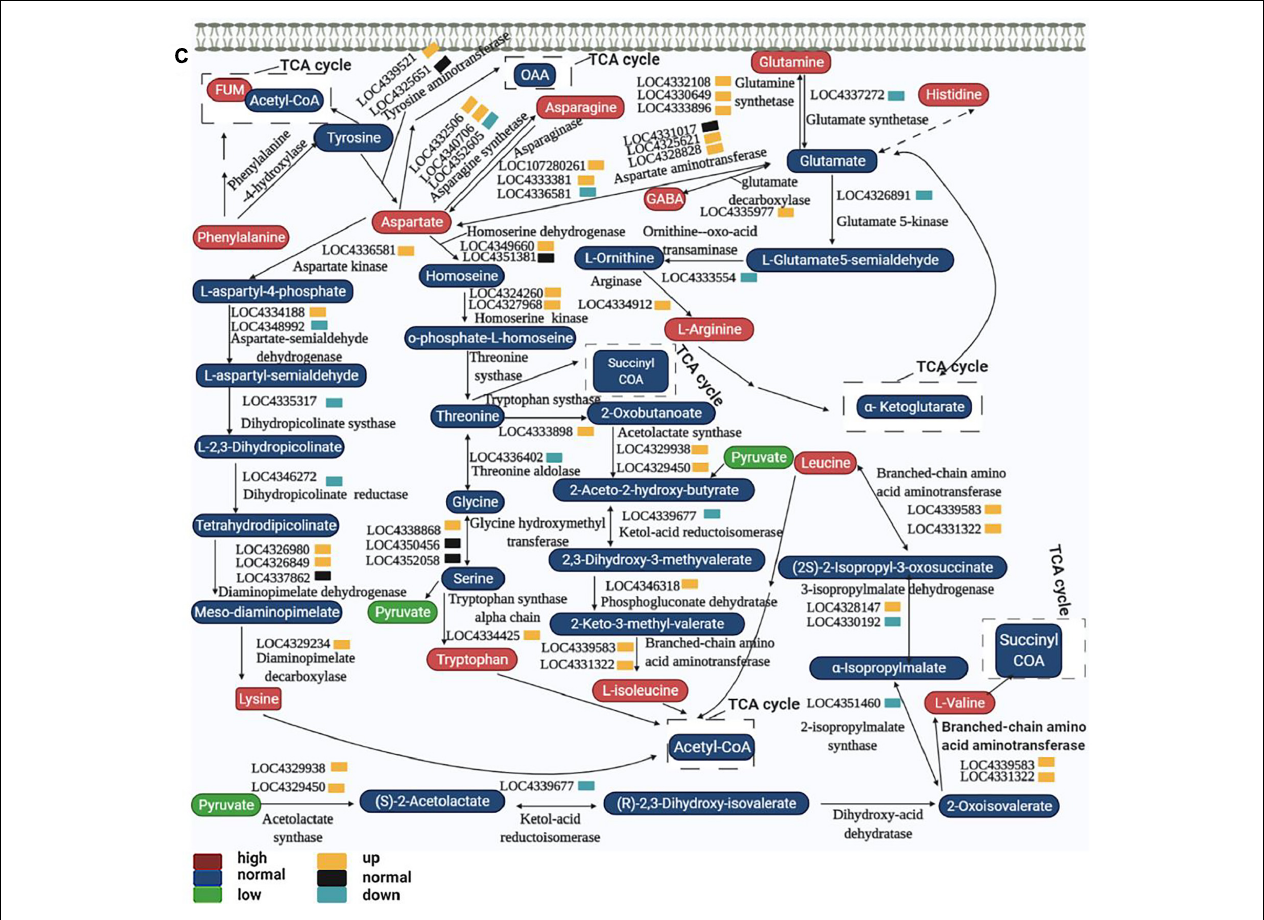
FIGURE 14 | Amino acid metabolism pathways of two rice varieties. After spaceflight, the two rice varieties developed into TLP and TS, respectively. TLP-DN3 (A) , TLP-DN6 (B) , and TS-DN6 (C) show changes in the expression levels of metabolites and genes mapped to amino acid metabolism pathways. The relative content of each metabolite in rice is displayed in the form of a heat map from low (green) to high (red), as shown by the color scale. Enzymes related to these pathways are marked in red, and genes encoding enzymes are placed next to them. Similarly, gene expression levels are represented by yellow (up-regulated) and cyan (down-regulated). Blue and black, respectively represent no significant changes in metabolites and gene